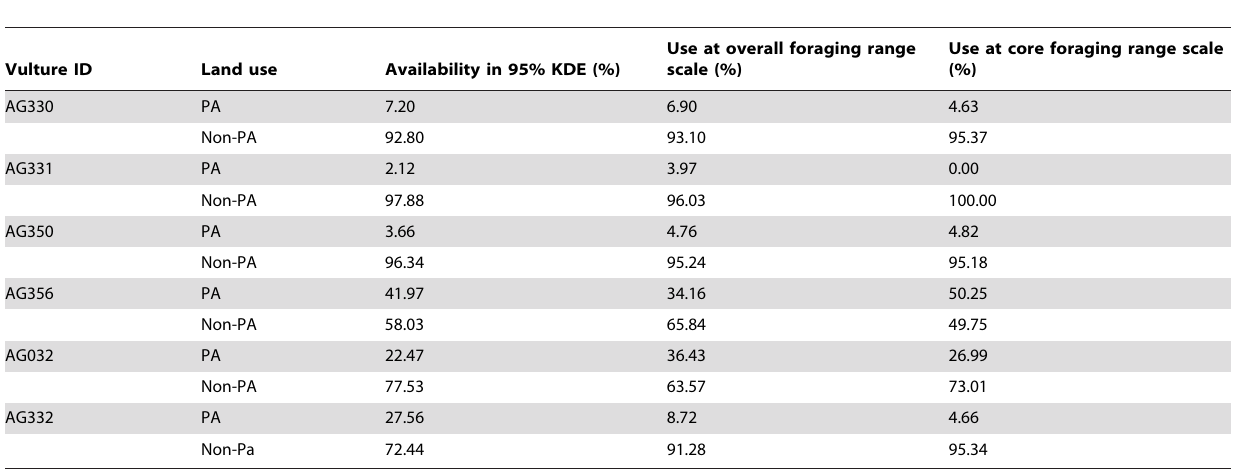
Table 2. Availability and use of protected areas by six immature African white-backed vultures at the overall and core foraging range scales.